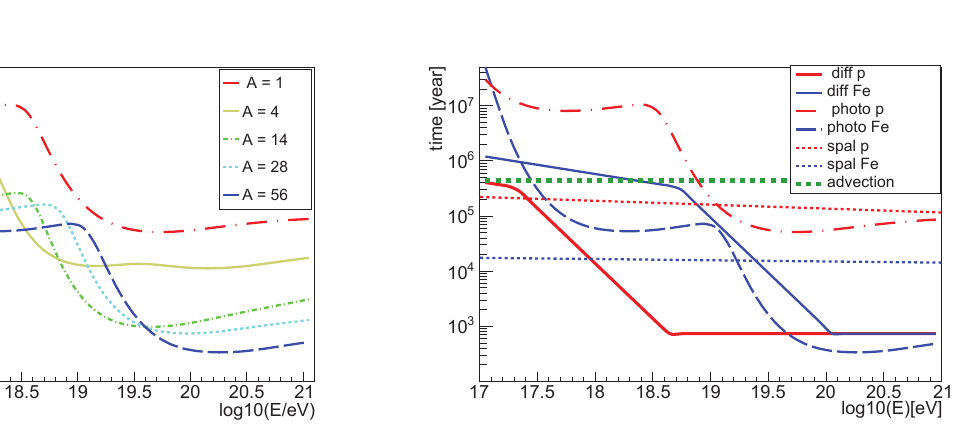
Figure 3. Interaction and escaping timescales for our prototype SBG: photo-hadronic interaction times (dashed-dot lines), spal- lation times (dashed lines) and di ff usion times (solid lines) for protons (red) and Iron nuclei (blue). The green dashed line is the advection